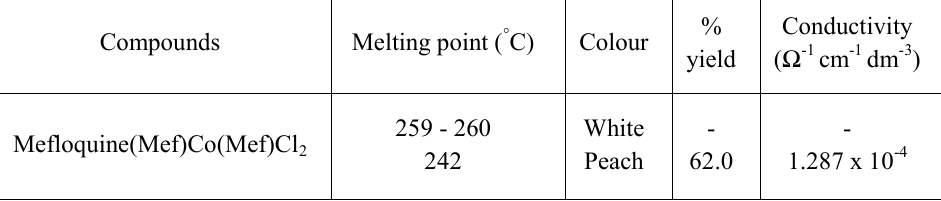
Table 1. Some physical properties of mefloquine and its metal complex.